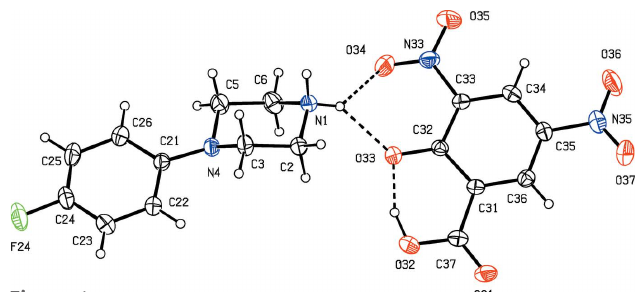
Figure 3 The independent components of compound (III) showing the atom- labelling scheme and the hydrogen bonds (drawn as dashed lines) within the asymmetric unit. Displacement ellipsoids are drawn at the 30% probability level.